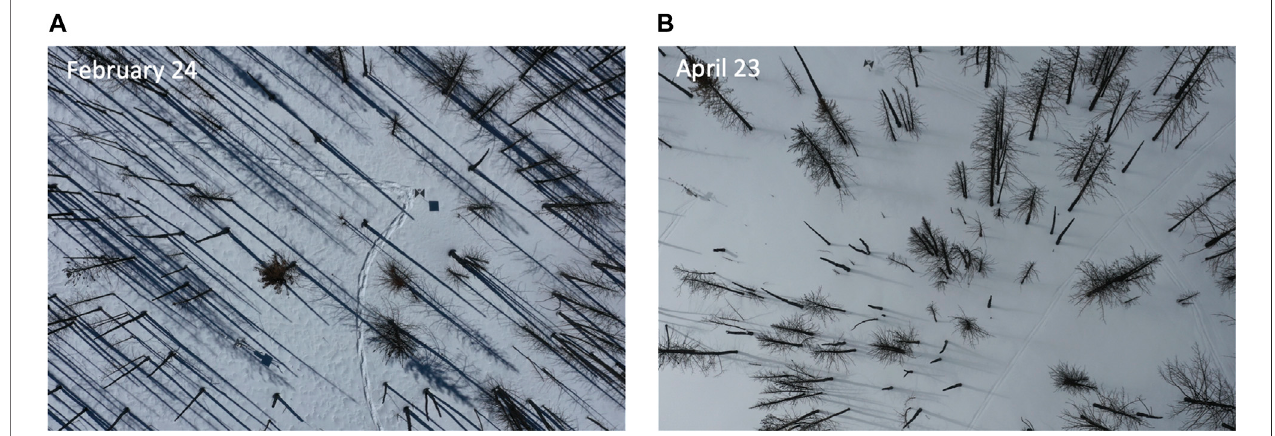
FIGURE 10 | Boxplots of the standard deviation of twt within all individual pixel on each survey date.